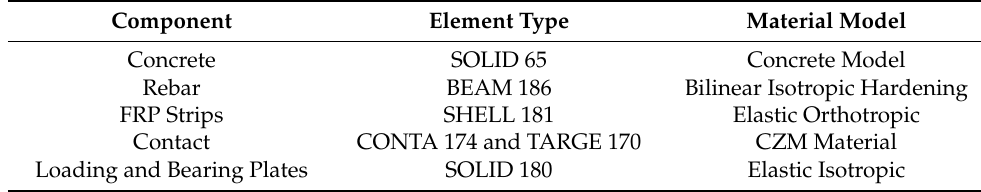
Table 3. Details of the Finite Element